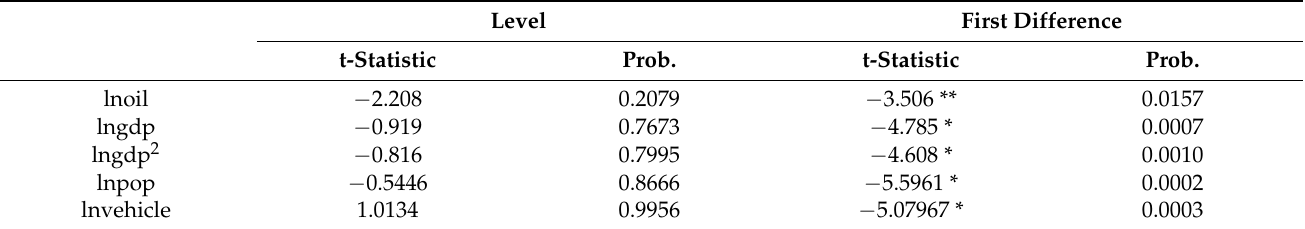
Table 2. Unit root test of